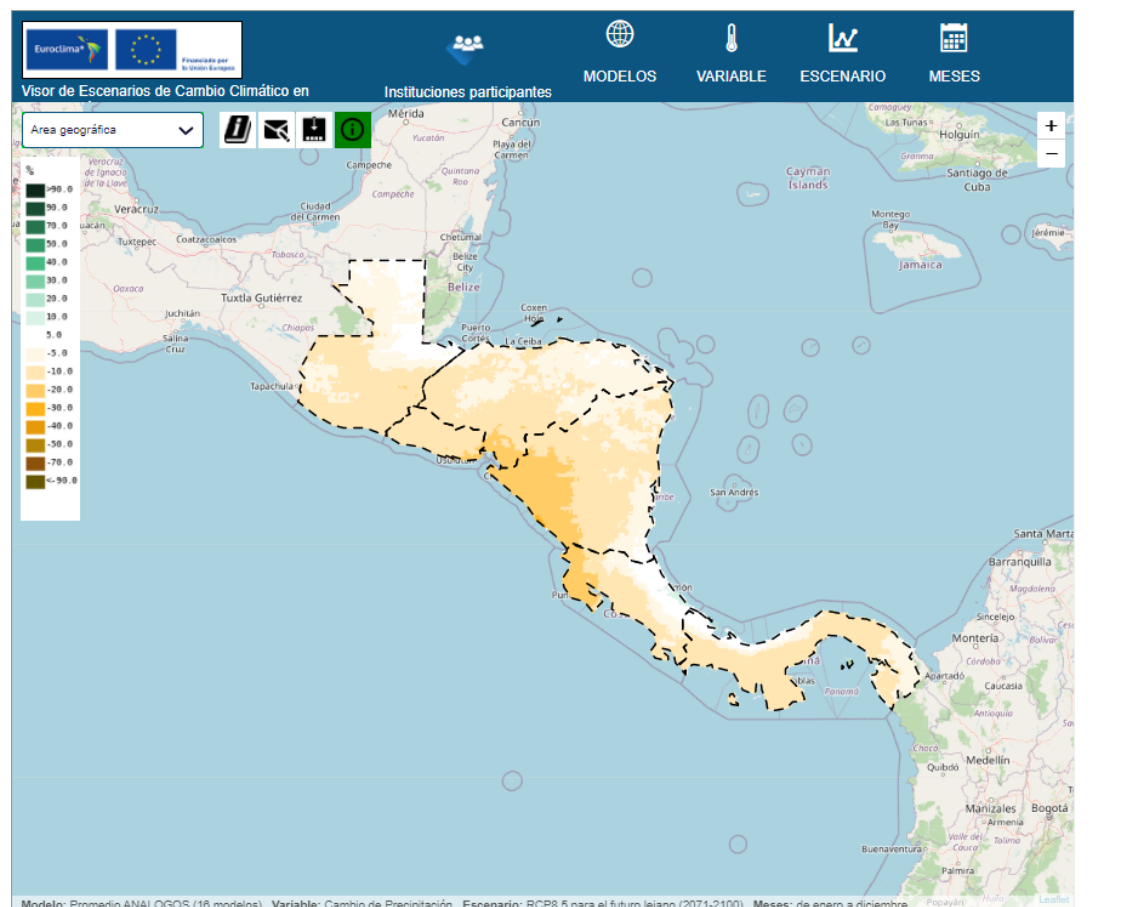
Figure 2. Screenshot showing viewer home